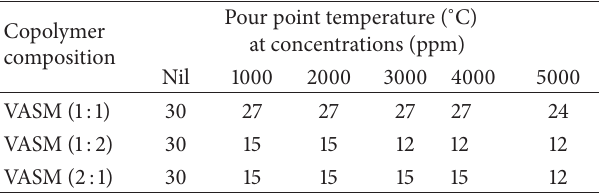
Table 4: The pour point of untreated crude oil and treated crude oil with